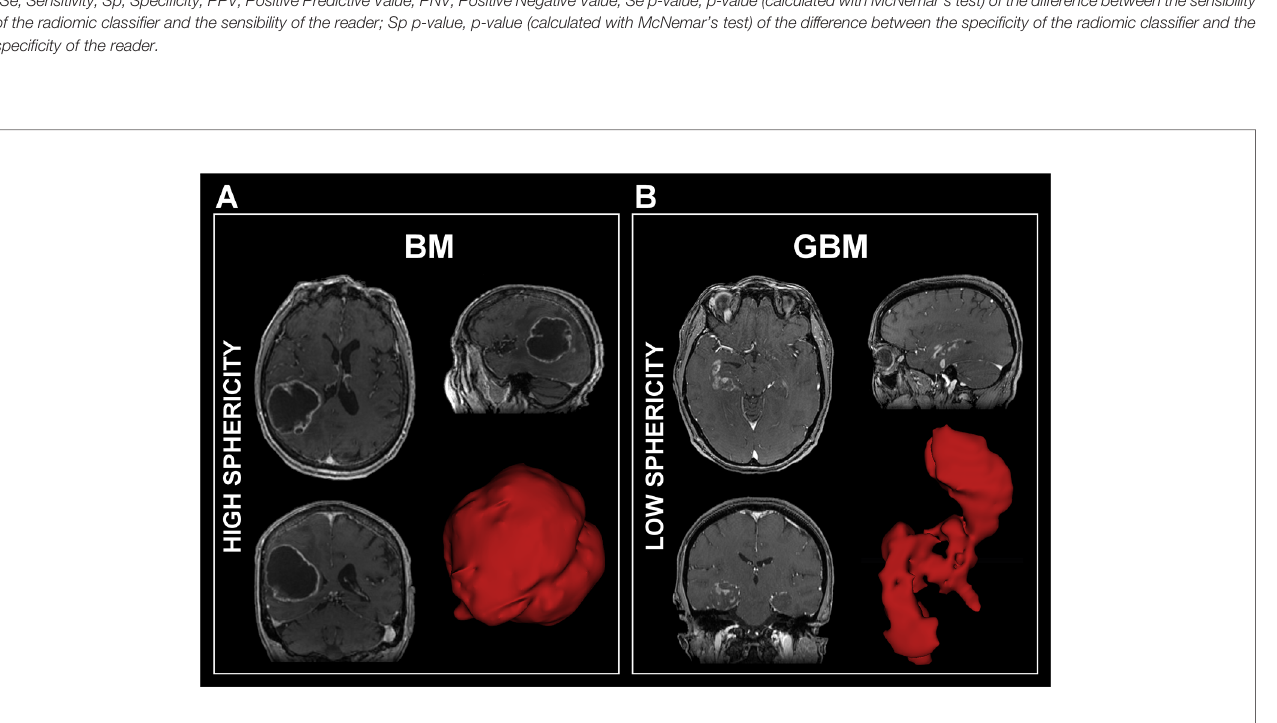
FIGURE 6 | Examples of 3D representation of a brain metastasis (A) for which the sphericity was equal to 0.76 and a glioblastoma (B) for which the sphericity was equal to 0.45. GBM, Glioblastoma; BM, Brain Metastasis.